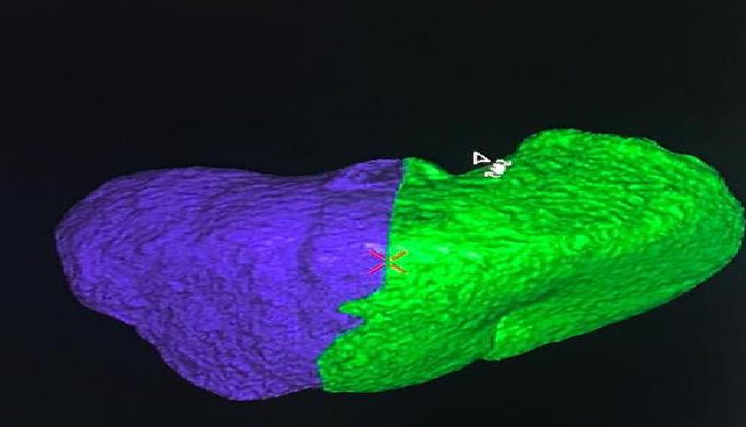
Figure 3. The Future Remnant Liver Volume (FRLV) (S1-S2-S3-S4), calculated with the “Hepatic VCAR” segmentation software on the Whole-body CT